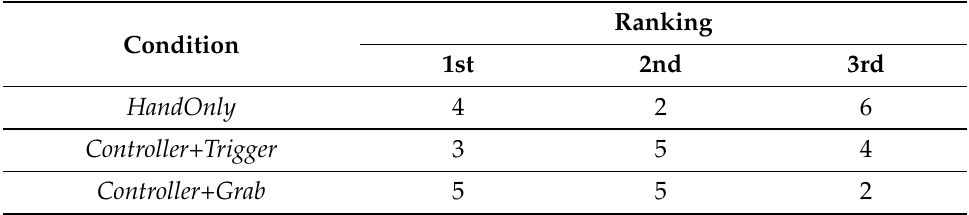
Table 5. The number of mentions when asking the participants to rank the interaction methods as the easiest to adopt, the second and the least easy.